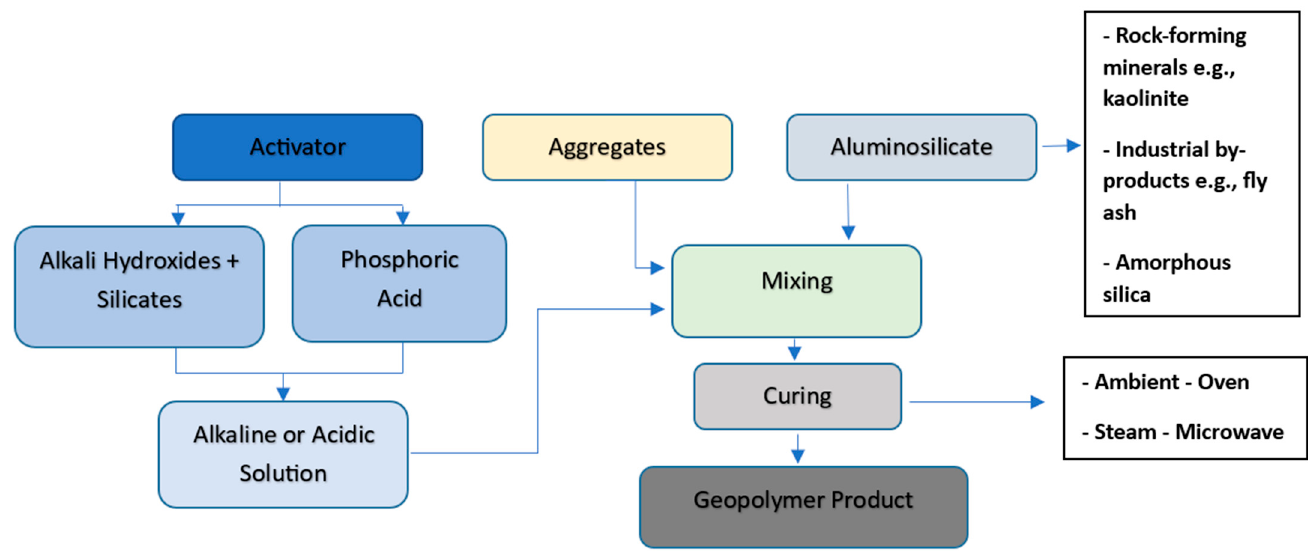
Figure 2. An overview of the geopolymer production process .